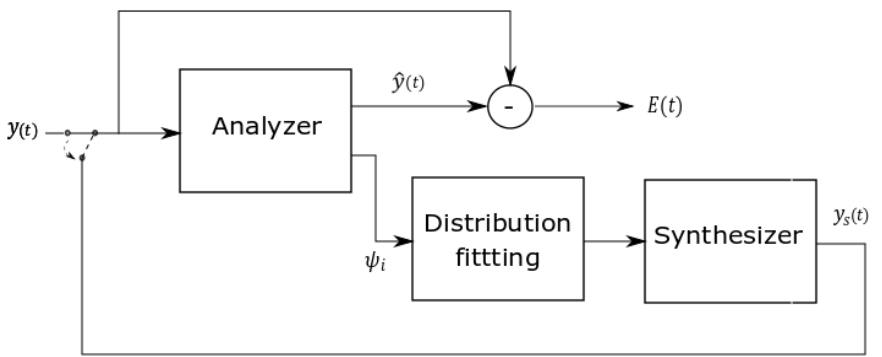
Figure 3. Overview of the analyzer and the synthesizer used for modelling and synthesizing GAWs. The analyzer models and estimates parameters of input GAWs, which is described in Section 2.2. The synthesizer described in Section 2.4 generates synthetic GAWs 𝑦 𝑠 (𝑡) is based on the distributions of the estimated parameters 𝜓 𝑖 that are fitted as described in Section 2.3.